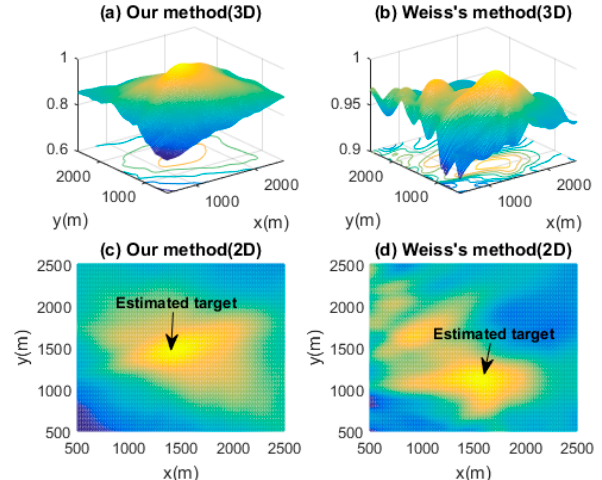
Figure 3. Pseudo spatial spectra of the DPD method using different parameter information. ( a ) Our method (3D); ( b ) Welss’s method (3D); ( c ) Our method (2D); ( d ) Welss’s method (2D).